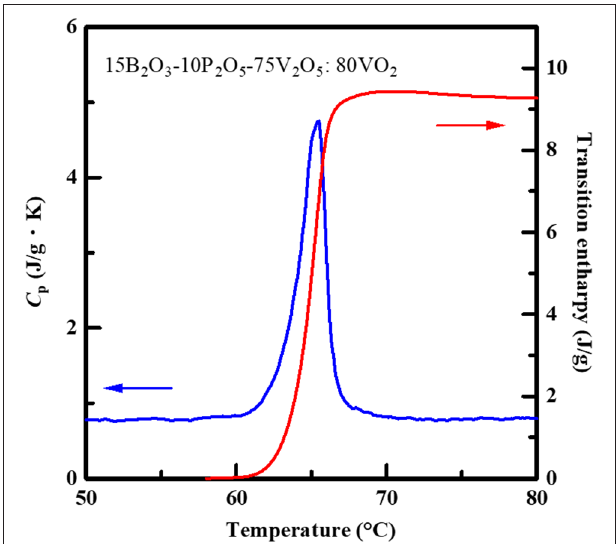
FIGURE 3 | Heat capacity and transition enthalpy for the VO 2 -dispersed glass in the B 2 O 3 -P 2 O 5 -V 2 O 5 system with x = 80. The transition enthalpy, 1 H , was obtained by thermodynamic treatment based on H = R C p dT because the enthalpy corresponded to the latent heat storage